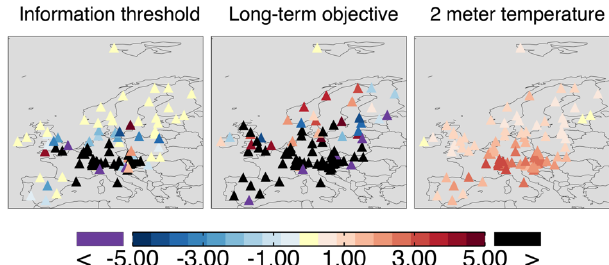
Figure 10. Spatial distribution of the exceedance anomalies in 2003, relevant to the averages over 1995–2002 and for the infor- mation threshold as well as the long-term objective, in comparison with the 2m temperature anomalies in each of the